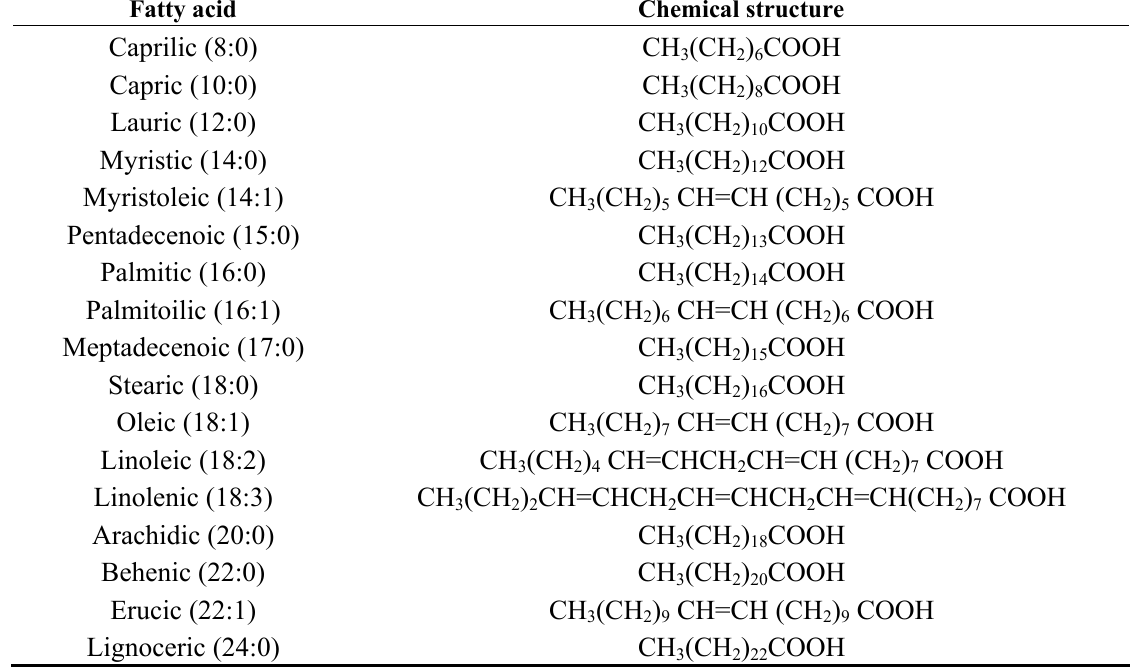
Fatty acid Chemical